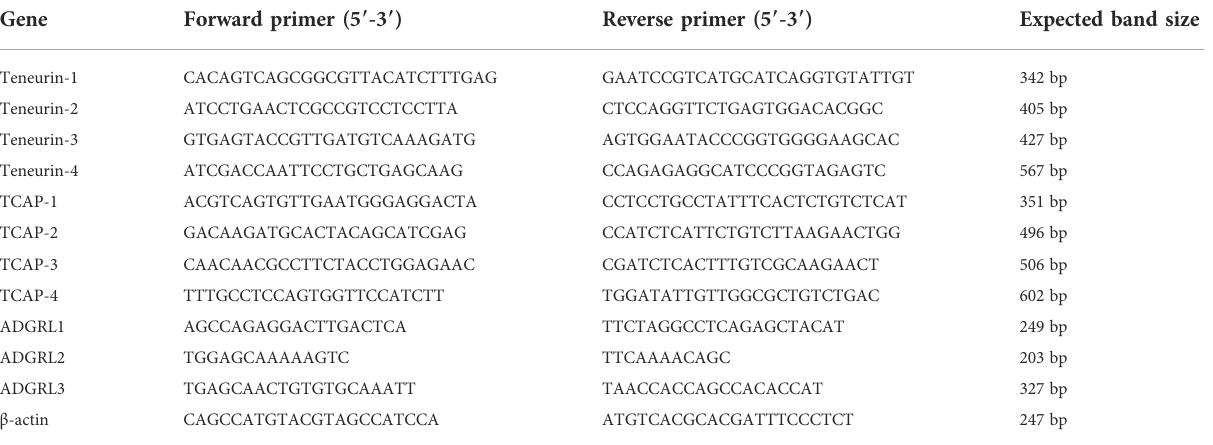
TABLE 1 Primers used for in vitro and in vitro RT-PCR analyses. Forward and reverse primer pairs for the four teneurins, TCAPs, three latrophilins (ADGRL), and β -actin control are indicated.